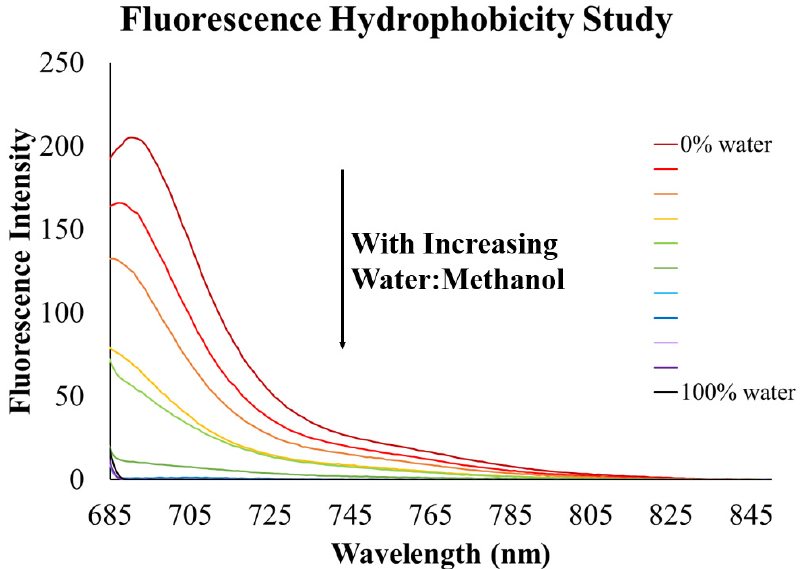
Figure 5. Fluorescence spectra of compound 5 (0.005 µM) in increasing percentages of water (0, 10, 20, 30, 40, 50, 60, 70, 80, 90, and 100%).